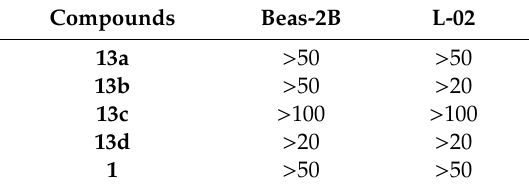
Table 3. Antiproliferative activities (IC 50 in µ M) of representative compounds against normal cells.